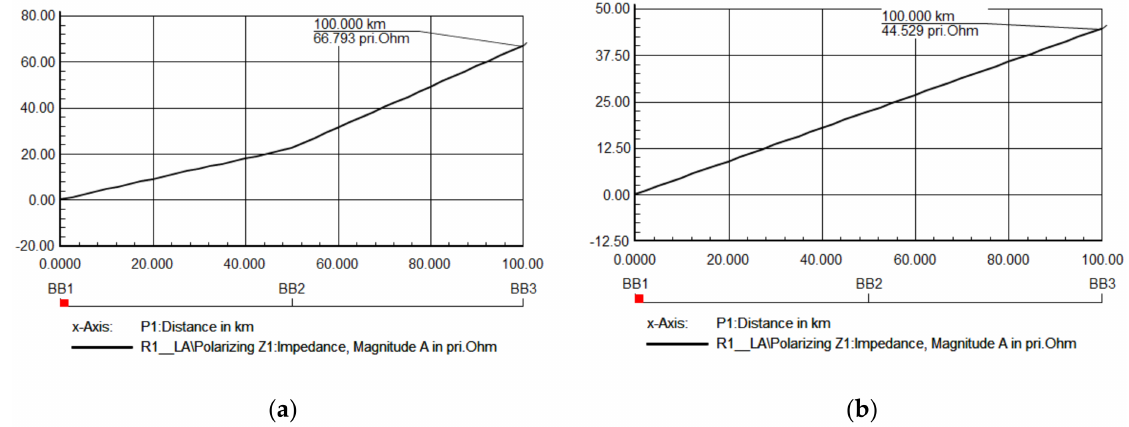
Figure 14. Short-circuit sweep ( a ) Both lines connected and ( b ) line B disconnected. 3.1.1. Analysis of an SLG at 80% on Line A with (a) Line A and B Connected and (b) Line B